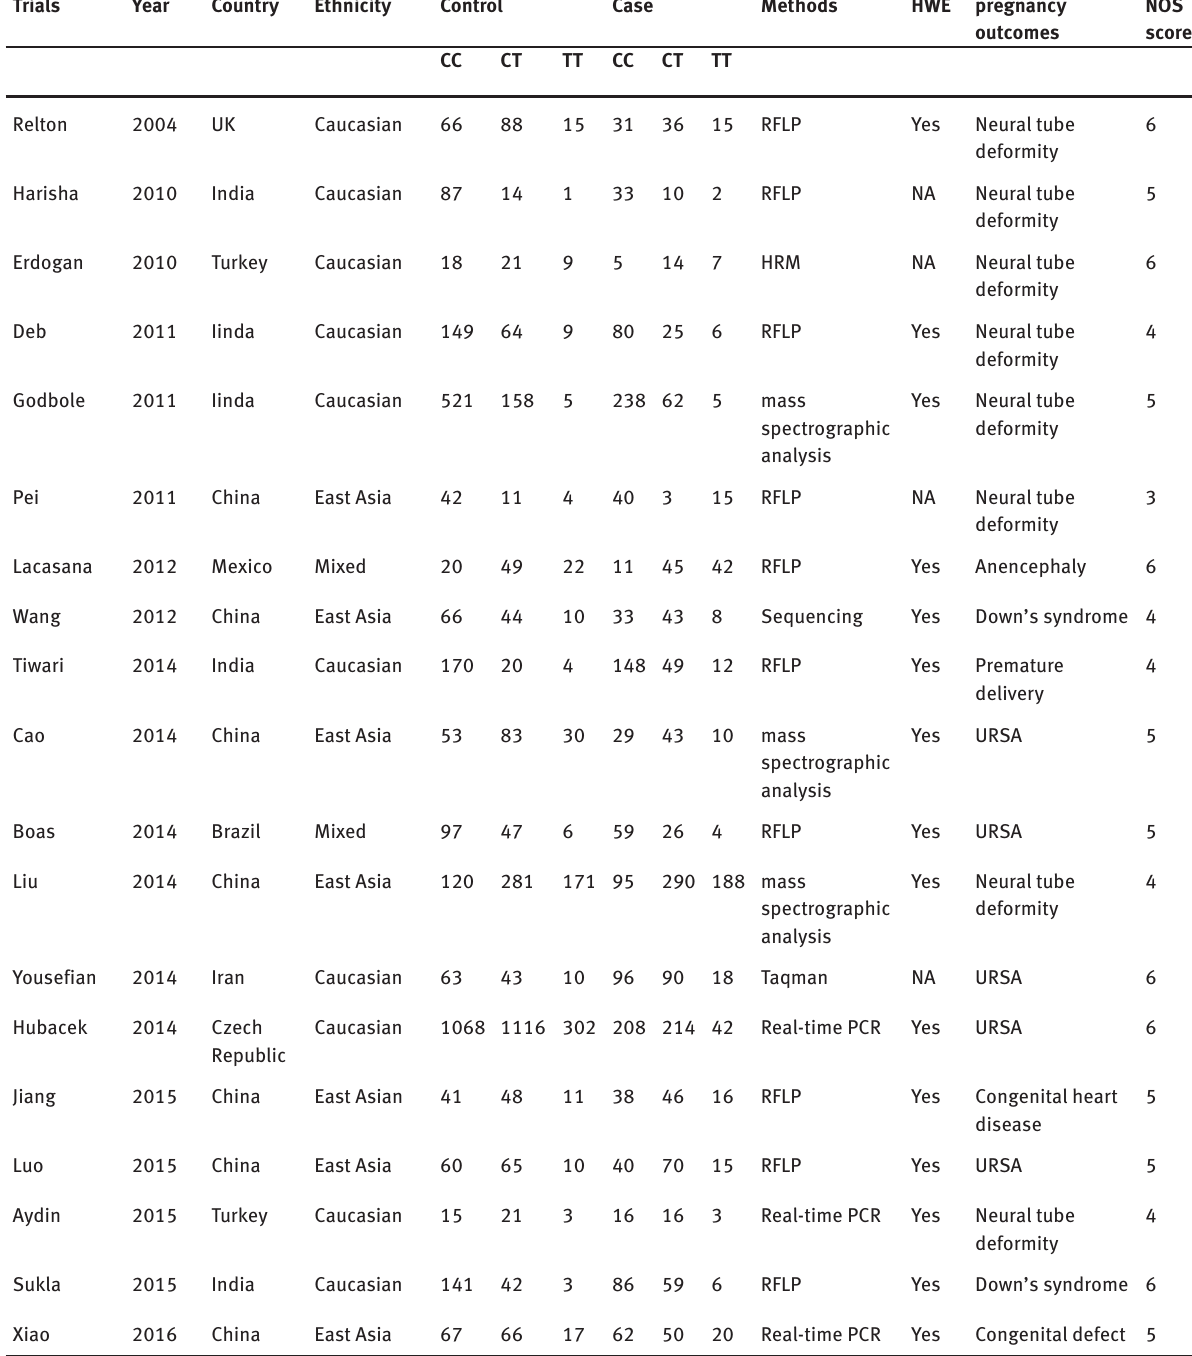
Table 1: General information on the included studies for evaluating the correlation between the methylenetetrahydrofolate reductase 677C>T gene polymorphism and fetal congenital